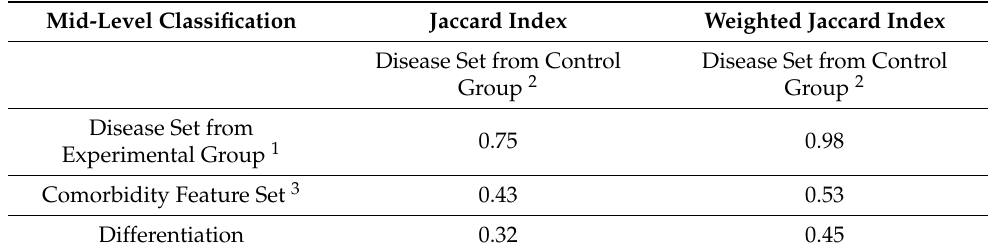
Table 4. Jaccard index and weighted Jaccard index similarities pairwise ALS_EG_FEA , ALS_CG_FEA , and ALS_SELECT_FEA (mid-level